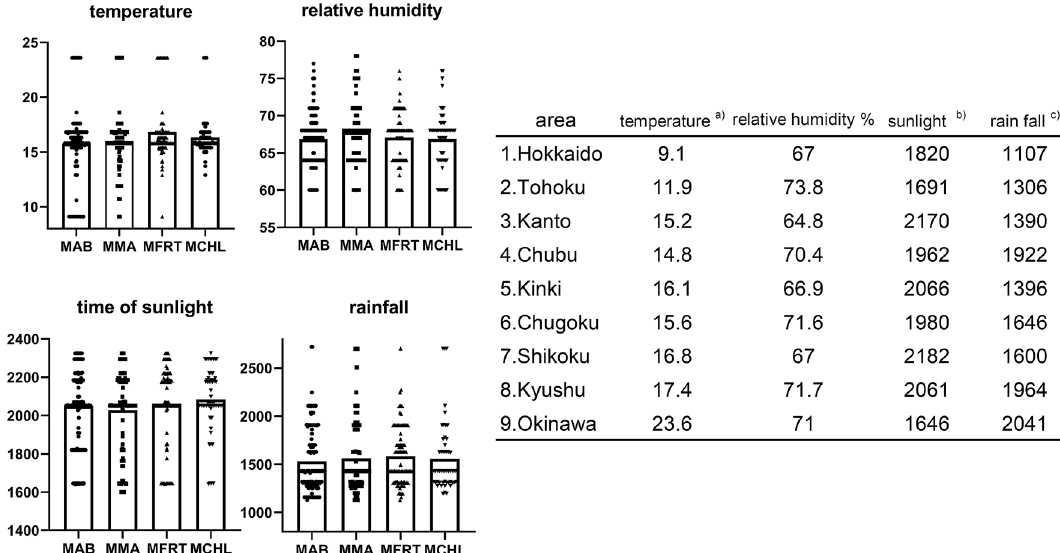
Figure 3. Weather conditions of the location where major rapidly growing mycobacteria species were isolated. ( a ) Temperature = average annual temperature, °C; ( b ) time of sunlight: h/year; ( c ) rainfall: mm/year. MFRT M. fortuitum , MCHL M.